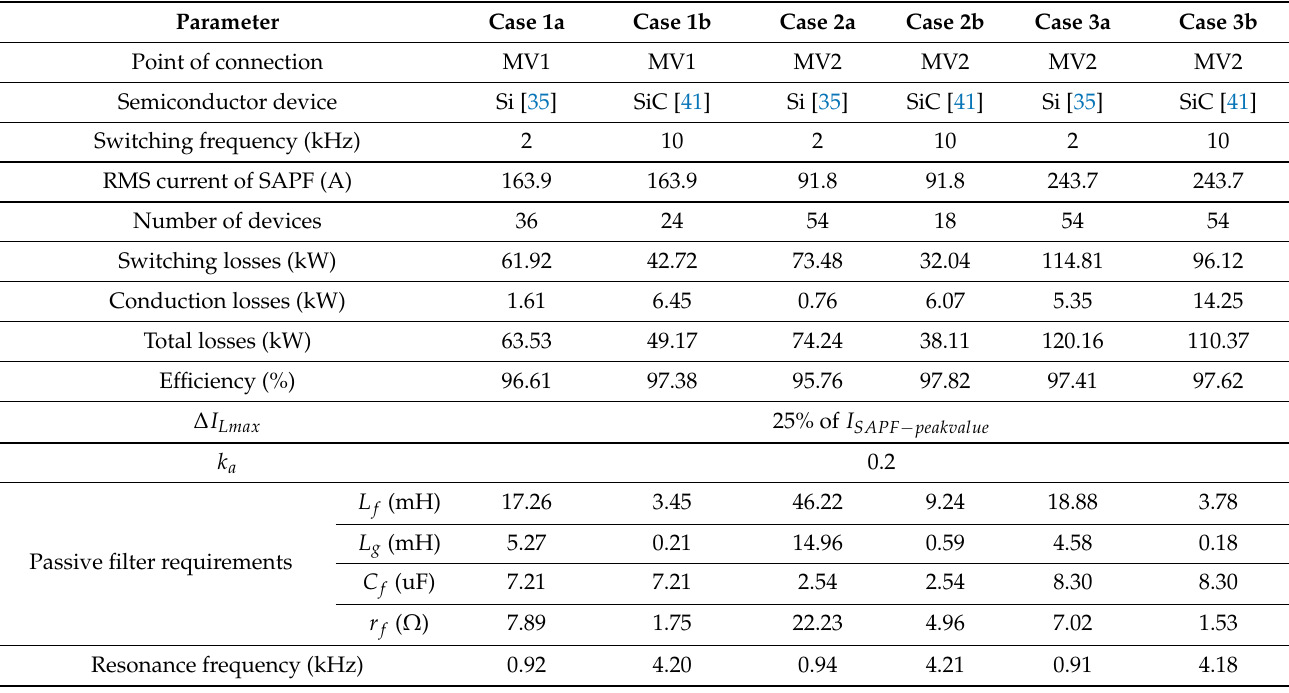
Table 5. Results of the SAPF